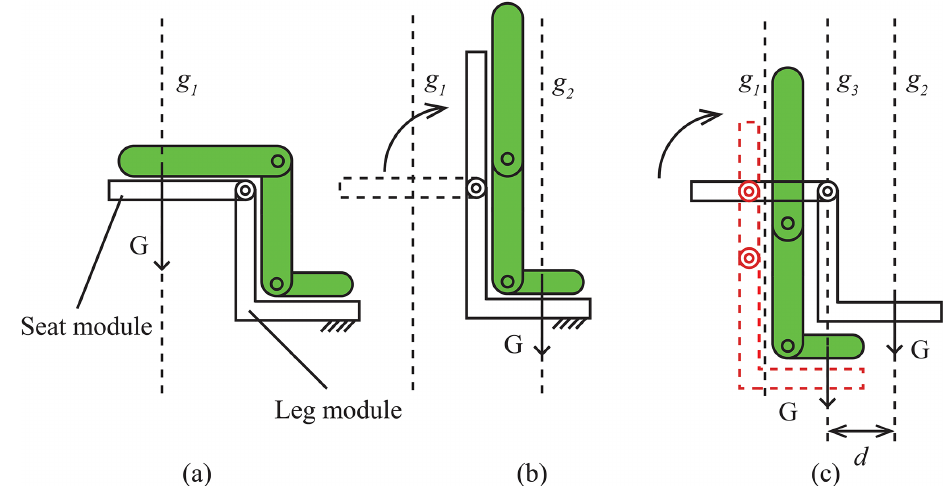
Figure 3. Human–wheelchair coupling model III. (a) Schematic diagram of a person’s CoG in the sitting posture. (b) Schematic diagram of a person’s CoG in the standing posture (current wheelchair). (c) Diagram of a person’s CoG in the standing posture (redesign of the seat